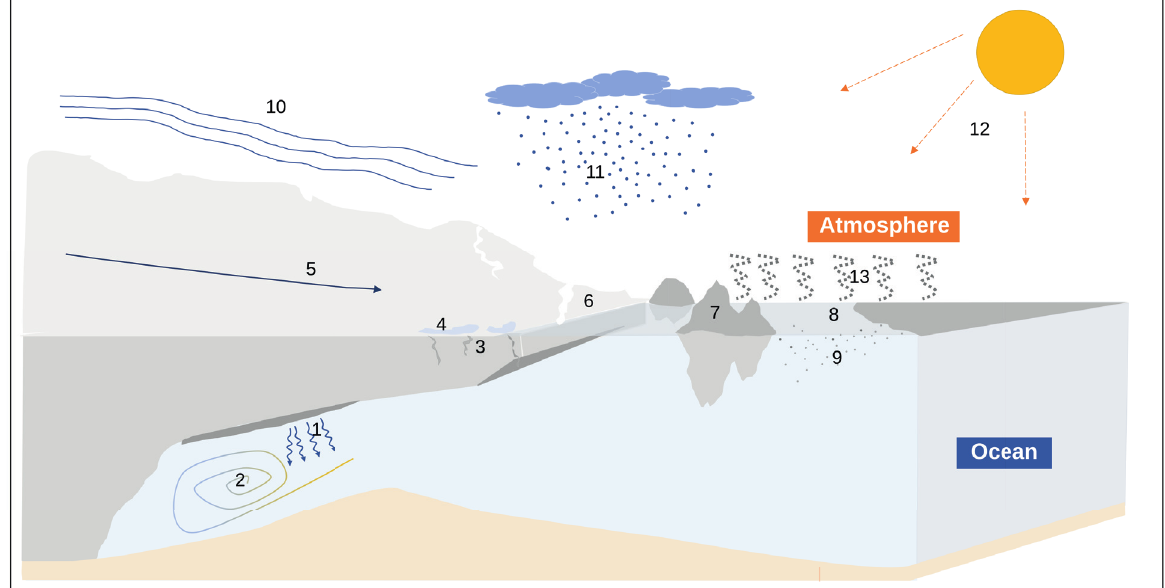
Figure 2. Water cycle over ice-shelves. 1. Basal melting – melting under ice shelf; 2. Water that upwells close to Antarctica is converted to denser bottom water by cooling and brine released during sea-ice formation; 3. Ice shelf crevasses – points of instability in ice-shelves where potentially can collapse; 4. Melting ponds – surface melting above ice-shelves; 5. Ice-velocity – ice movement from the continent into the ocean through ice-shelves; 6. Ice-shelves disintegration – formation of icebergs; 7. Icebergs – ice portions fl oating in the ocean; 8. Sea-ice – ice formatted by the cooling of the ocean as heat lost into the atmosphere, it causes brine rejection, increasing salinity in the ocean near these regions; 9. Salt rejection from sea-ice formation due brine rejection;10. Westerly and katabatic winds – contributing in the evaporation and heat transfer from continent, ocean and atmosphere; 11. Snow and precipitation; 12. Solar radiation; 13. Evaporation and